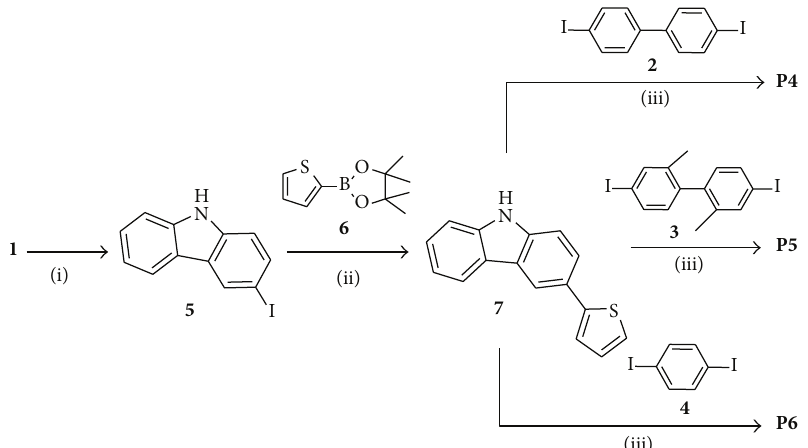
Scheme 1: Synthesis of P4 , P5 , and P6 . (i) I 2 (0.5 eq), AcOH, and reflux. (ii) K 2 CO 3 , Pd(PPh 3 ) 4 , EtOH, and reflux for 24 h. (iii) K 2 CO 3 , copper powder, 18-crown-6, o -DCB, and reflux.